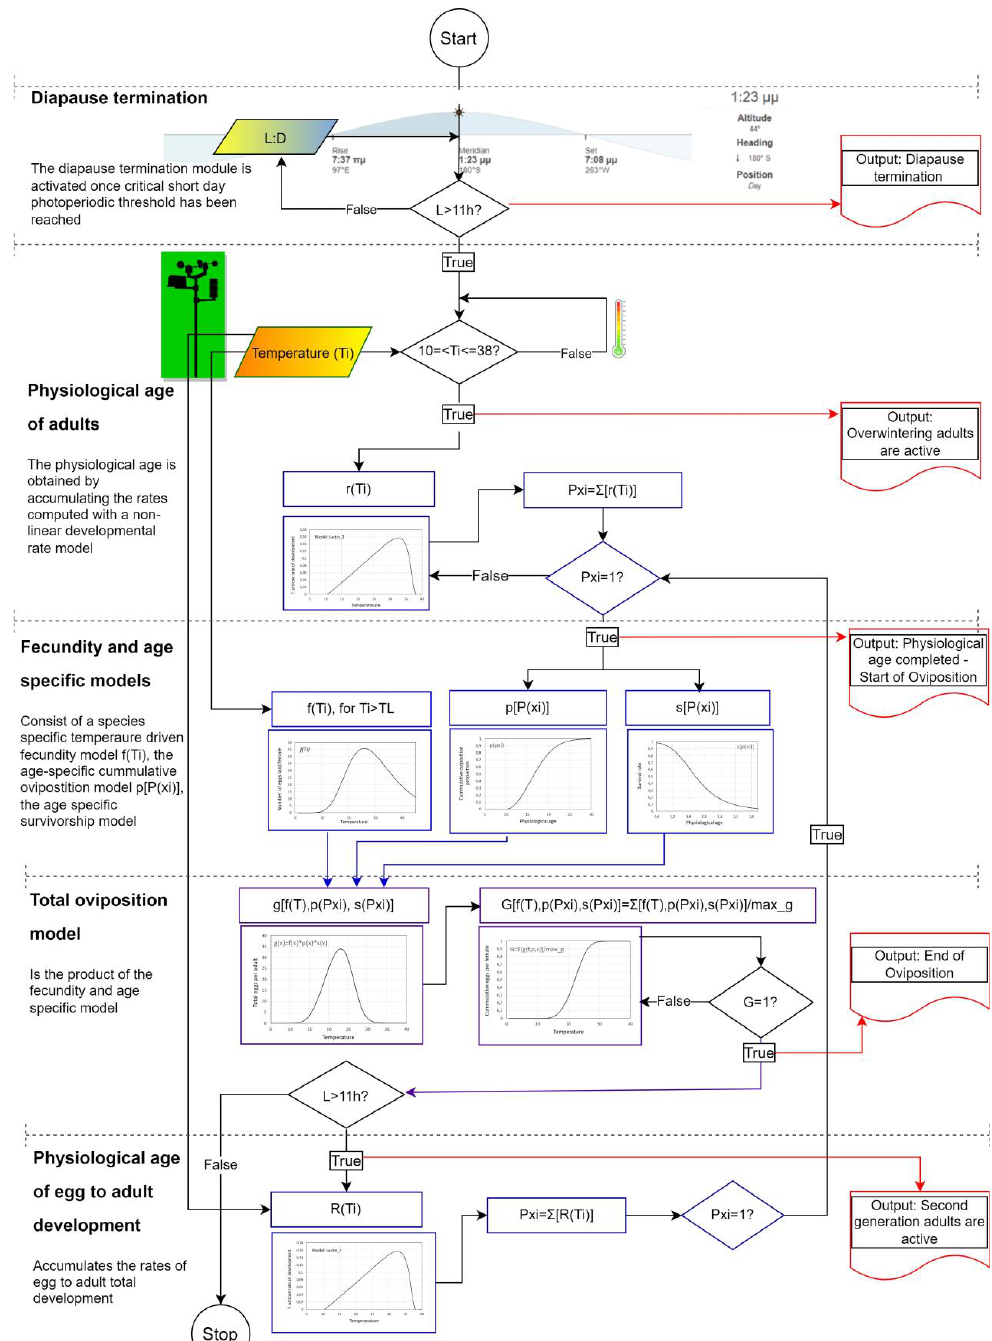
Figure 2. Conceptual rate summation model scheme and related algorithm developed for simulating and predicting T. urticae phenology in dry bean cultivations under field conditions. The model consists of accumulating the development rate every day from the egg laying date. The development of a given stage is completed when the accumulation of development rate reaches one, and then the same calculation is made for the following larval stages. The beginning (first day of development of the first individual who reached the stage), the end (last day of development of the last individual who reached the stage), and the mean duration of each instar, as well as the percentage of individuals therein, were also